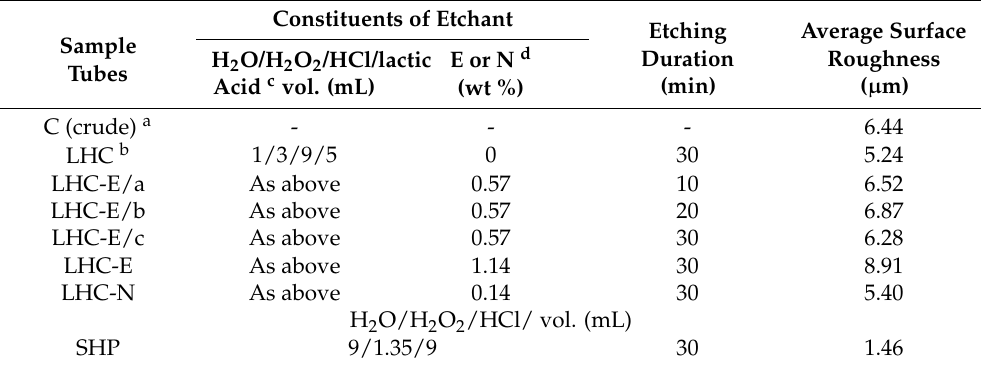
Table 1. Variation in the surface roughness of the inner wall of the SS-321 tube with the change in etching